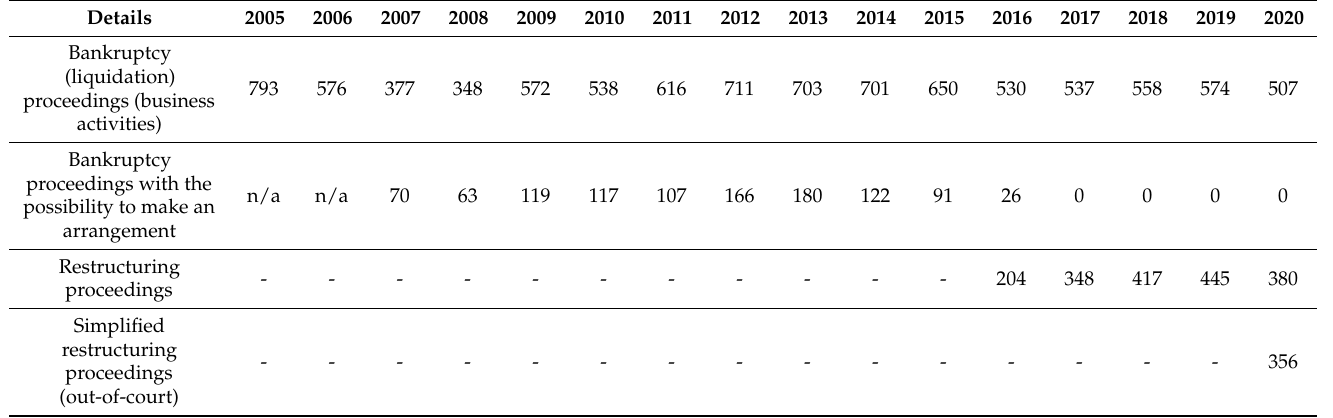
Table 1. Bankruptcies and restructurings in Poland in 2005–2020.